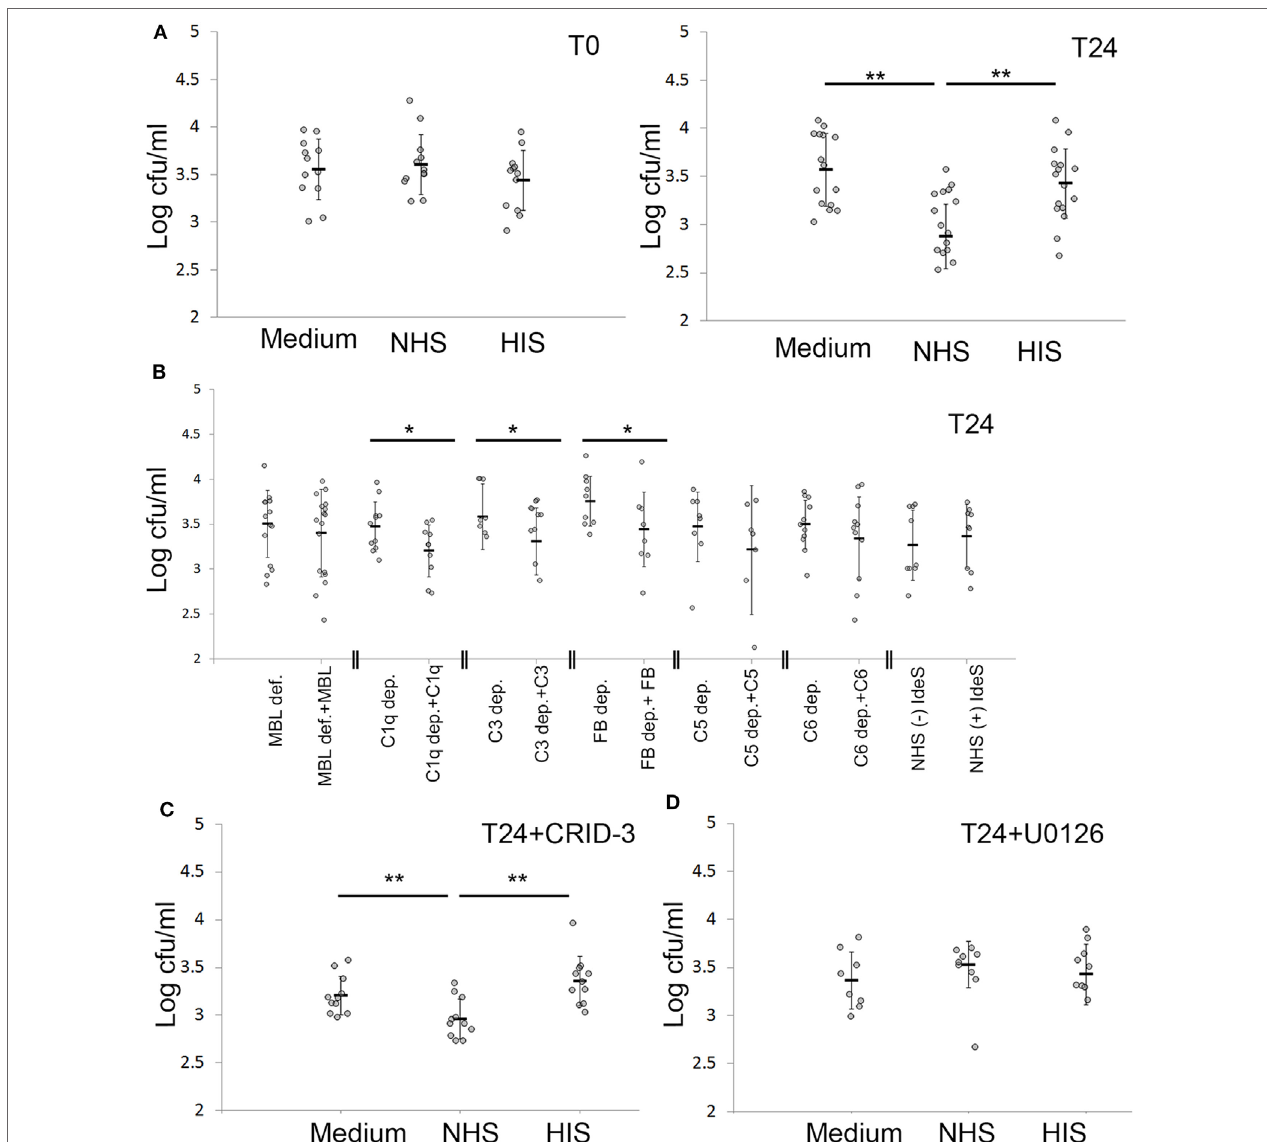
FigUre 6 | Keratinocytes actively cleared intracellular Staphylococcus aureus (SA) after complement activation. (a) Keratinocytes infected with SA for 24 h were treated with normal human serum (NHS)/HIS, then lysed and intracellular bacteria plated, either directly after complement activation (T0) or after 24 h (T24). (B) Depleted/deficient sera along with the respective reconstitution proteins were used to underline the complement components essential for bacterial clearance. (c) The inflammasome inhibitor CRID-3 was used to investigate if the effect seen is related to inflammasome activation, the effect of NHS on viable counts was not changed. (D) Treating infected keratinocytes with the ERK inhibitor U0126 abrogated the effect of NHS on bacterial viable counts. Each gray dot represents a keratinocyte monolayer. Black bars represent the average, and error bars represent standard deviation. * p < 0.05, ** p < 0.01. Each experiment was repeated at least three times, experiments using depleted sera are independent and are only compared with the respective reconstituted